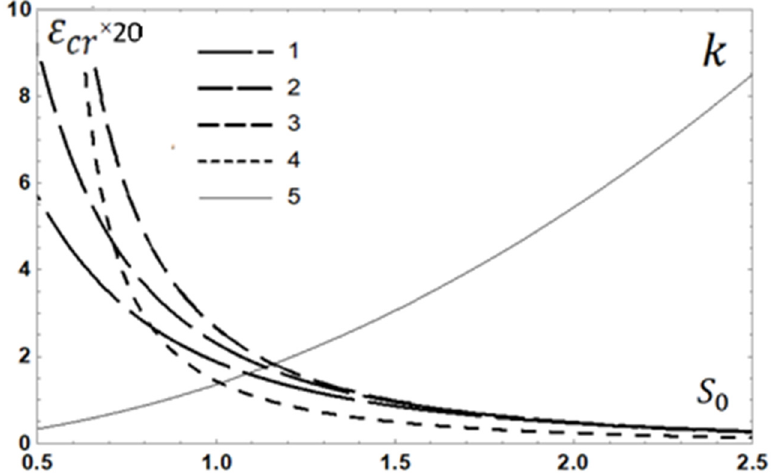
Figure 3. Dependence of the critical value, ε k , and parameter k from the steepness of the initial wave, S 0 , for the different initial wave locations, y 0 , and different geometries of the seafloor given by the parameter α : 1 ∼ α = 1, and y 0 = 1 (linear beach, no step); 2 ∼ α = 1, and y 0 = 1.5 (linear beach, no step); 3 ∼ α = 1, and y 0 = 3 (linear beach, no step); 4 ∼ α = 0.5, and y 0 = 3 (sloping beach with vertical step down (cavity) connected with horizontal seafloor); and 5 ∼ k ( S 0 )